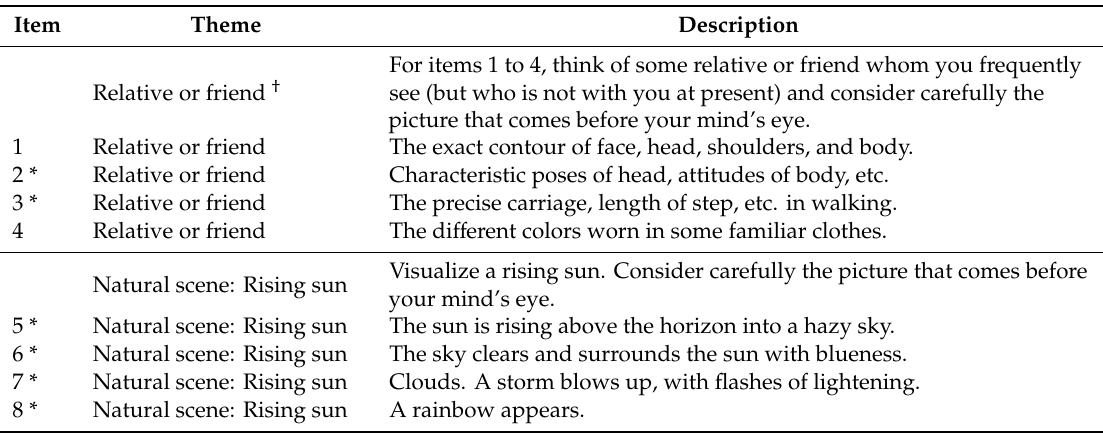
Table 2. Items in the Vividness of Visual Imagery Questionnaire [4]